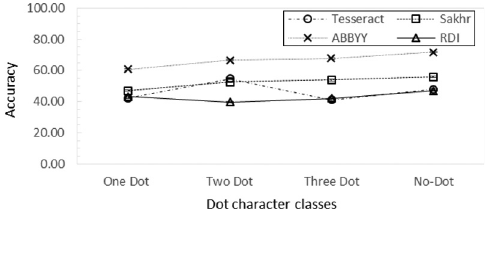
Figure 6. Dot character accuracy based on baseline results from